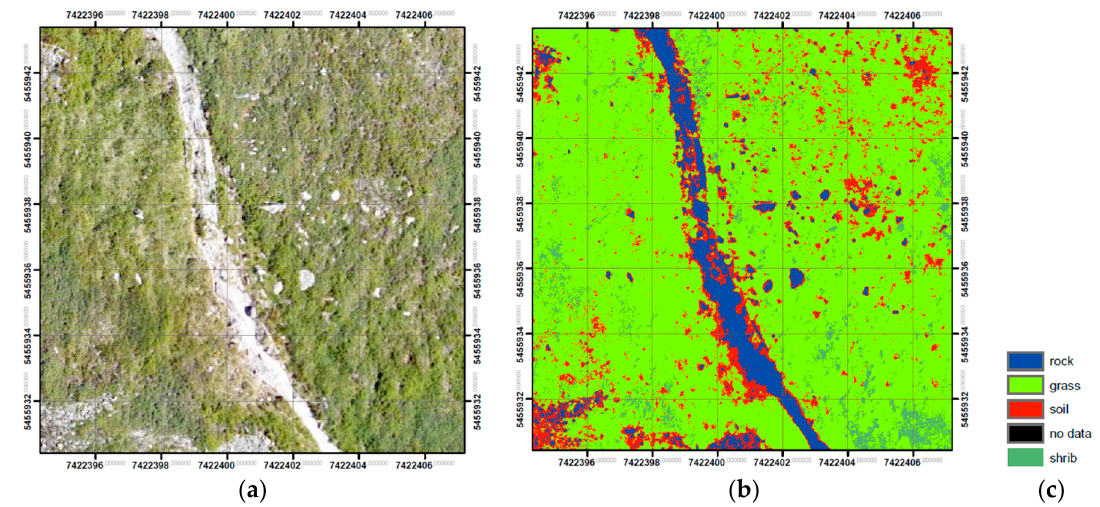
Figure 20. ( a ) An extract from the orthophotomap including the area of Kopa Kondracka (the area undergoing the floral succession); ( b ) the land cover map created by means of supervised classification; ( c ) legend (source: authors’ own study).